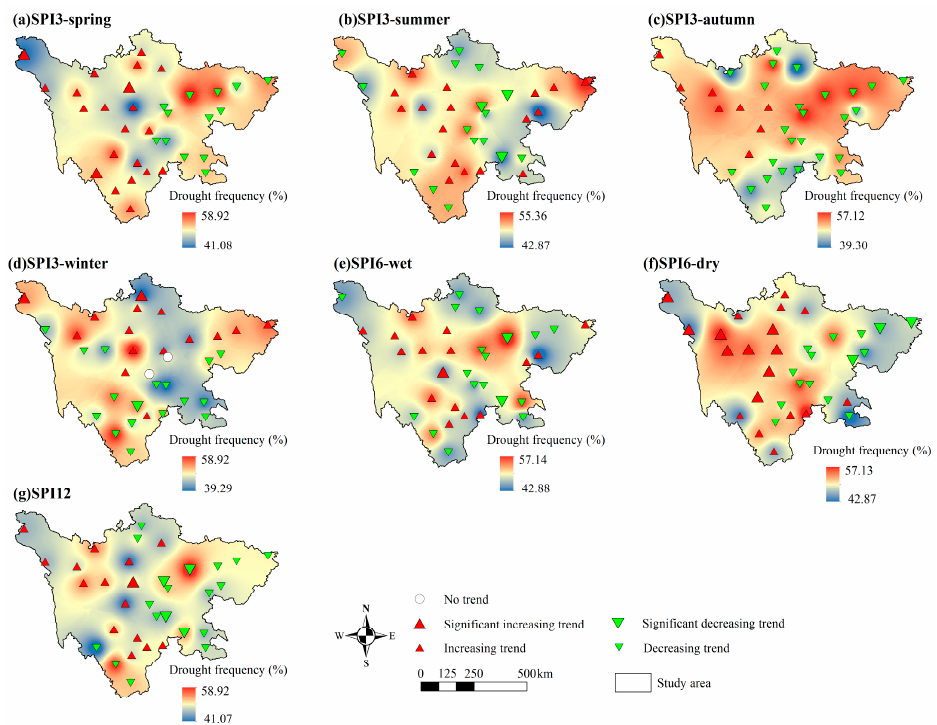
Figure 2. Spatial patterns of drought frequency and trends in SPI in Sichuan Province during 1961 − 2016, ( a − d ) for SPI3, ( e − f ) for SPI6, and ( g ) for SPI12.